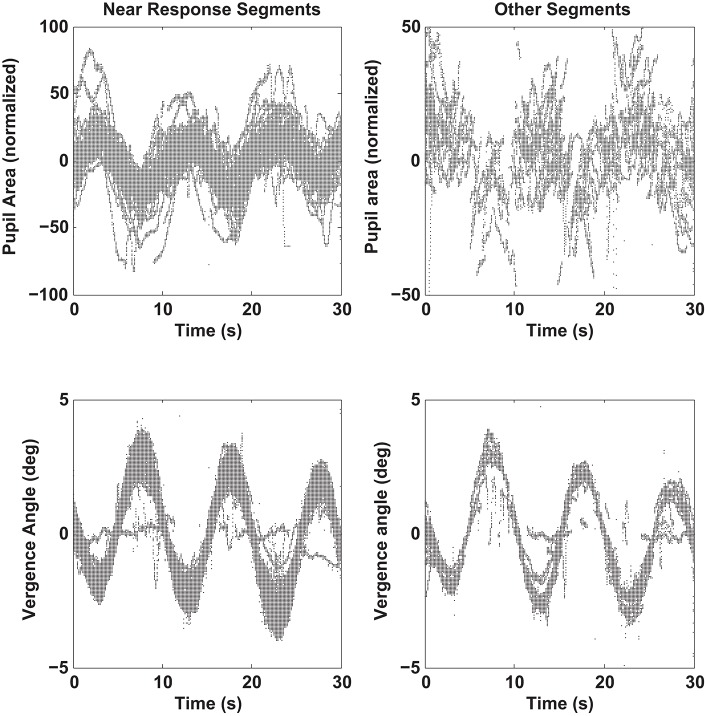
Pupil size recordings (upper graphs) and vergence angle recordings (lower graph) are shown for data segments showing a negative linear relationship between pupil area and vergence angle (“Near Response Segments,” left side) and for segments showing either a positive linear relationship between pupil area and vergence angle or a flat relationship (“Other Response Segments,” left side). Segments of detrended data from all subjects are superimposed, including one outlier subject with little vergence tracking. Note the out-of-phase modulation of the pupil and vergence traces for the “Near Response Segments”.